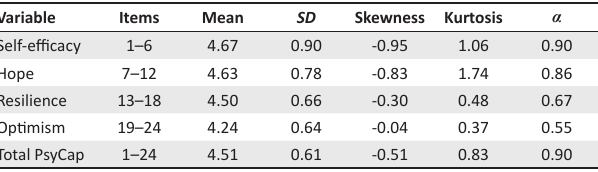
TABLE 3: Descriptive statistics, Cronbach’s alpha coefficient of the original PCQ factors.